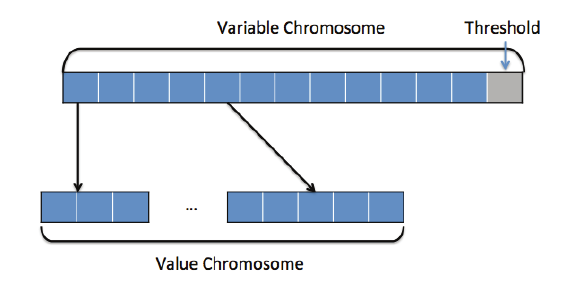
Fig. 5. Representation of a population individual in